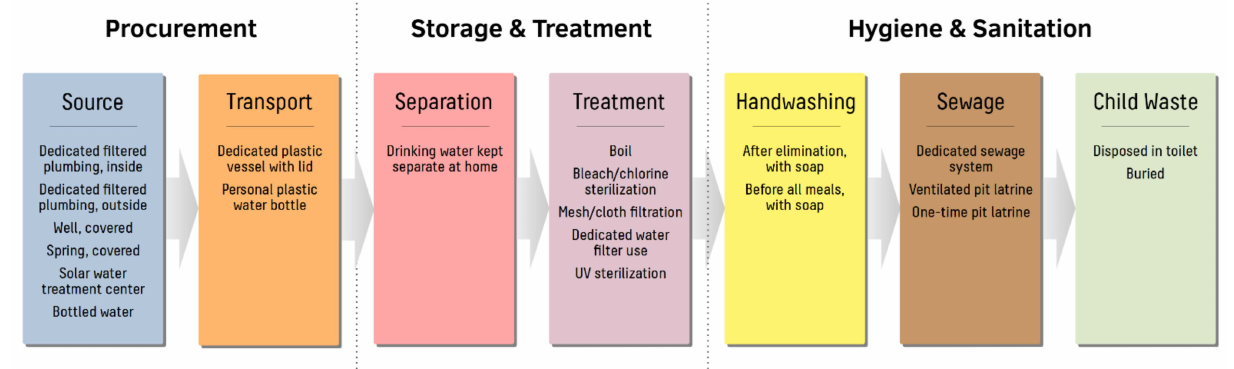
Figure 2. Definitions of clean water, sanitation, and hygiene (WASH) practices in central